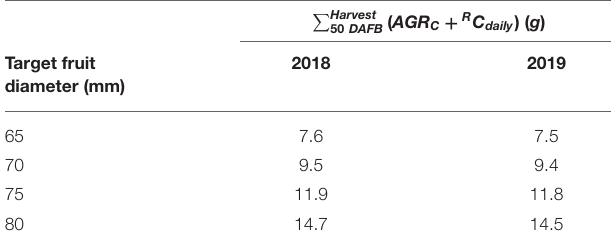
TABLE 1 | Total fruit C demand calculated from the sum of absolute C-based growth rates (AGR C ) and respiratory C loss ( R C daily ) of ‘Gala’/M.9 apples of the four targeted fruit diameters for the period of 50 d after full bloom (DAFB) till harvest in 2018 and